Question: Summarize what this figure shows in one sentence.
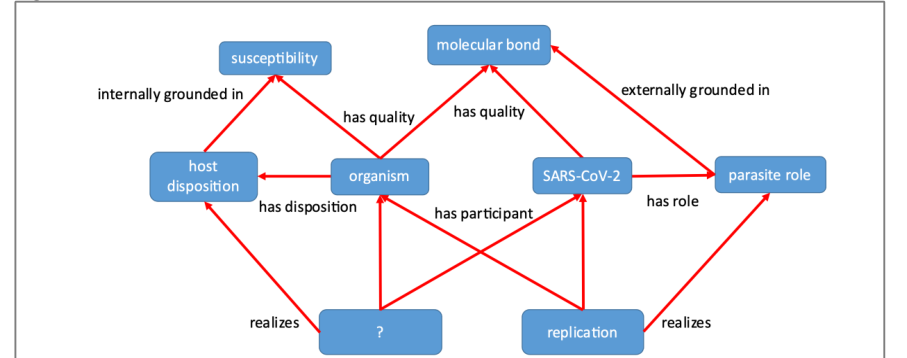
Answer: Host Dispositions and Pathogen Roles    4. Discussion  Our proposal clarifies relationships among dispositions, roles, and qualities within the  BFO Treatment. We thus provide a supplement to ontologists using these terms to model  such phenomena in various domains. Our proposal, moreover, provides precision to  commonly used metaphors that make these terms obscure to those unfamiliar with the  philosophical literature underwriting relevant definitions. Roles are realizable entities  inhering in some member of an aggregate which bears a relational quality in which it is  grounded; dispositions are realizable entities inhering in some entity which bears a  quality or qualities that provide the grounds for the disposition.     There are of course limitations to our proposal worth noting. For example,  implementing our proposal would require the inclusion of a new relation to BFO. BFO  has undergone several changes in the past decade, moving from BFO 1.0 and 1.1 to BFO  2.0 to t